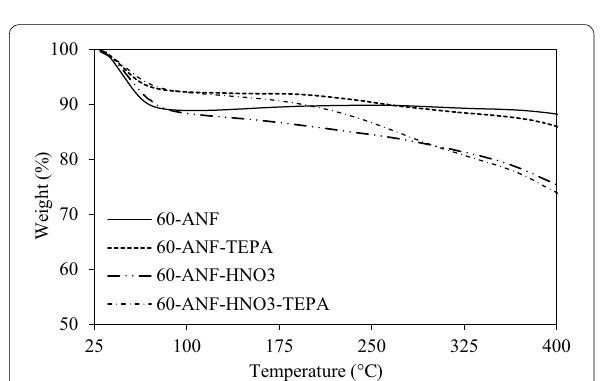
Fig. 4 Thermograms showing slopes that are indicative of the thermal stability of ANFs